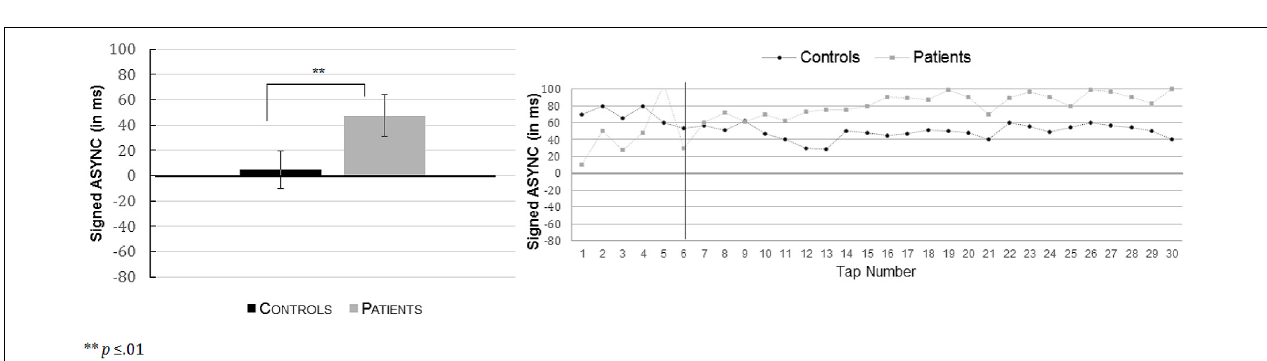
FIGURE 5 | Mean signed asynchronies (ASYNC in ms) (with their respective standard errors) in the alternating non-isochronous rhythmic condition ( Left : R-alt) as a function of the group (controls versus patients). On the (Right) , the time series of these results are presented for the total of 30 taps in controls (black dots) and in the patients (gray dots). The black vertical line illustrates the boundary from which the first six taps of each trial was discarded for the analyses. Indeed, it took a few beats for the participants to get into the pace set by the metronome.